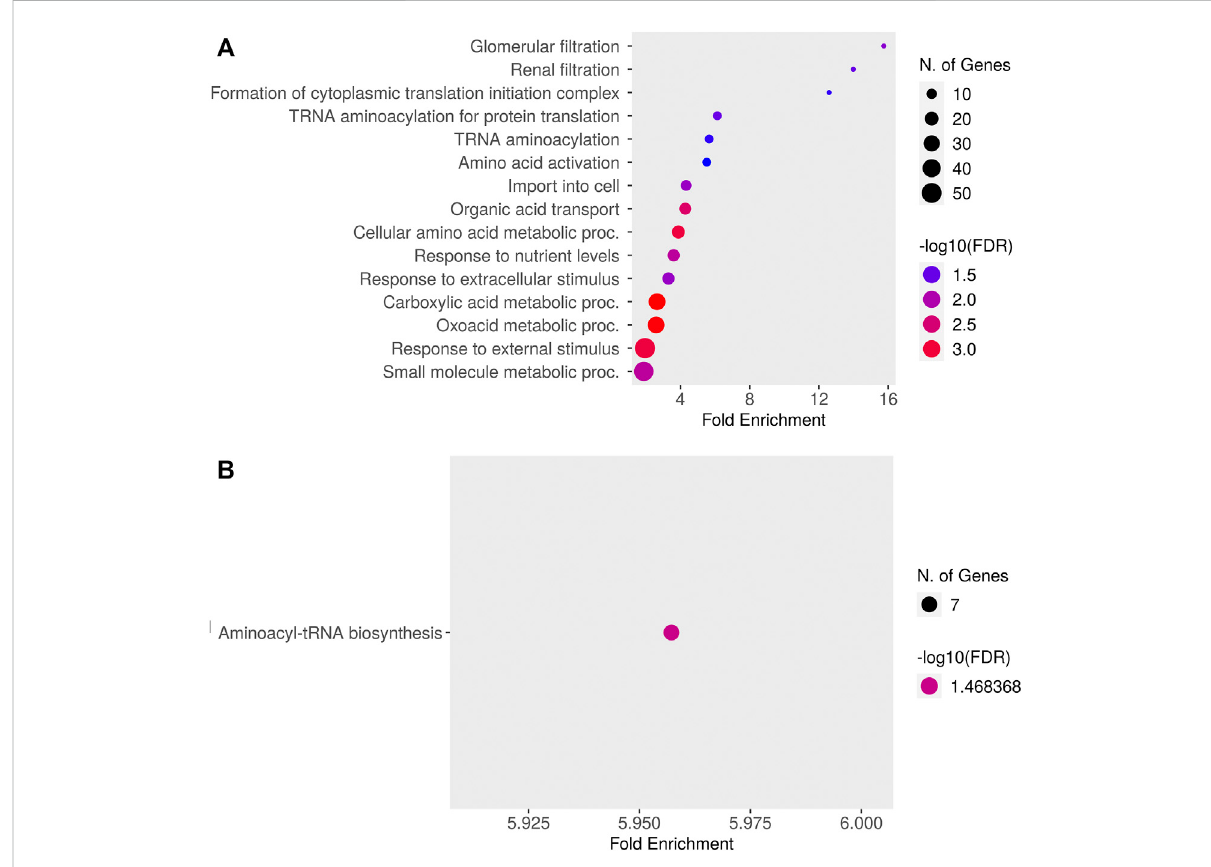
FIGURE 5 Dotplot of (A) Gene Ontology (GO) Biological Processes and (B) Kyoto Encyclopedia of Genes and Genomes (KEGG) pathways enriched for genes differentially expressed in the lactating udder at 24 h post dexamethasone.